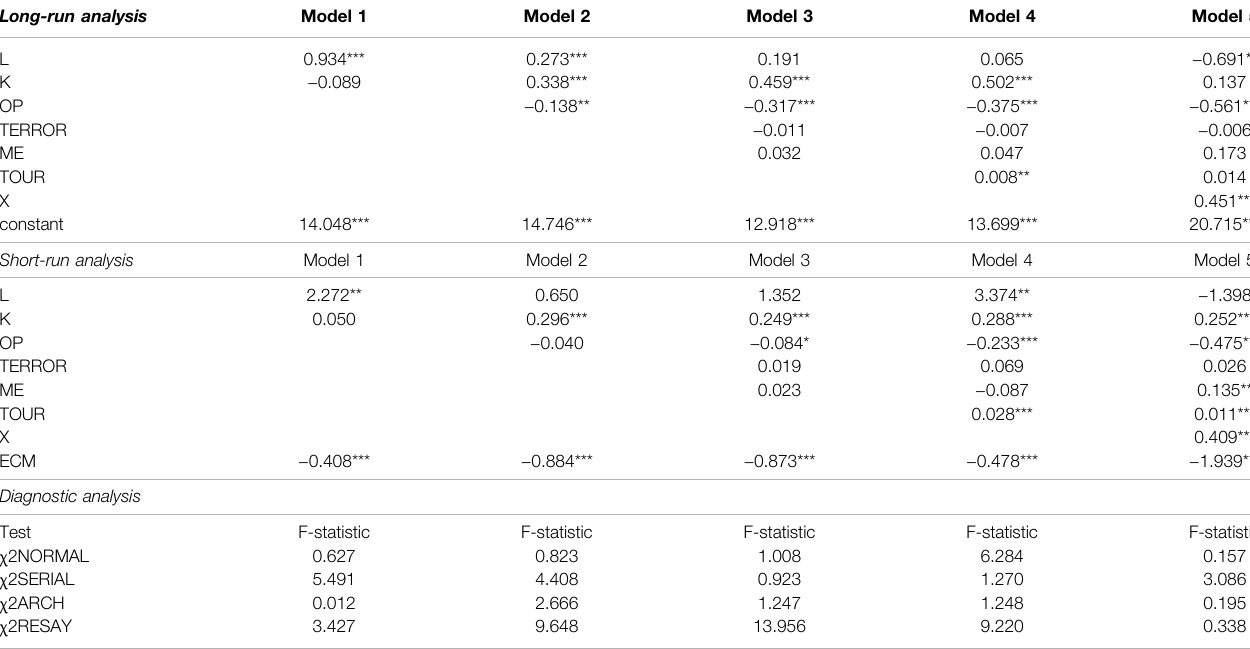
TABLE 6 | ARDL long-run and short-run